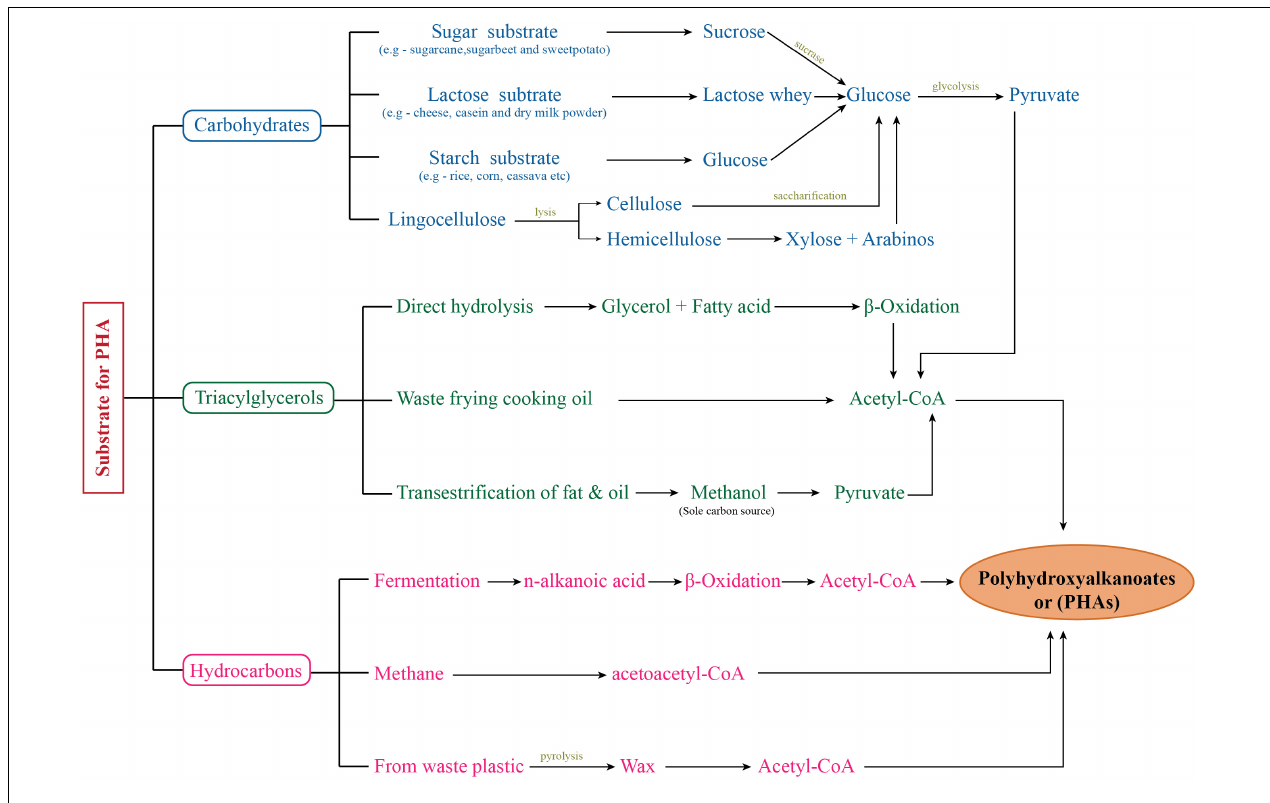
FIGURE 1 | Flow chart showing PHA production from diverse